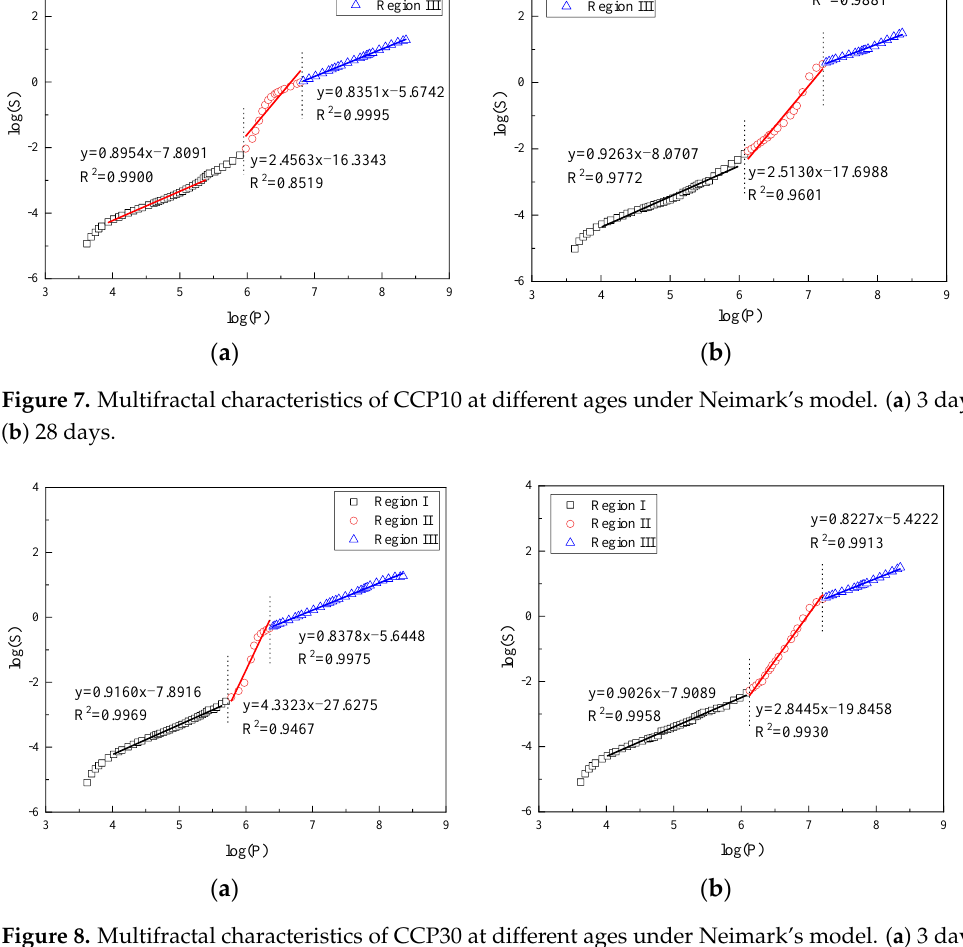
Figure 8. Multifractal characteristics of CCP30 at different ages under Neimark’s model. ( a ) 3 days, ( b ) 28 days.